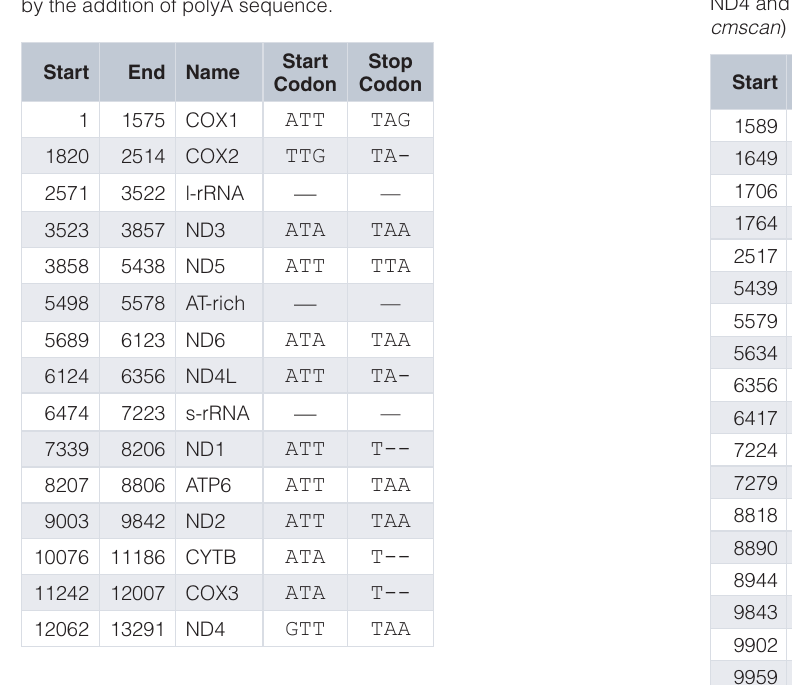
Table 1. mtDNA gene regions. Predicted gene features from the Nippostrongylus brasiliensis mitochondrial genome. Stop codons that end in hyphens (-) are completed by the addition of polyA sequence.